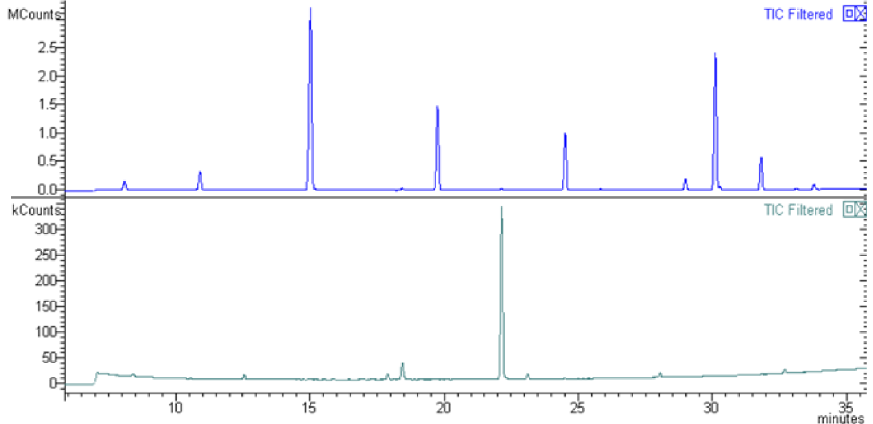
Figure 4. GC-MS overlapping chromatograms of SRO raw material and one of the aliquots of GSF tested (in triplicate, see the supplementary file). The upper graph shows the peculiar picks of fatty acids present in SRO (raw material) that completely disappeared in the lower graph (Lipomatrix specimen), clearly indicating that no SRO release from Lipomatrix has